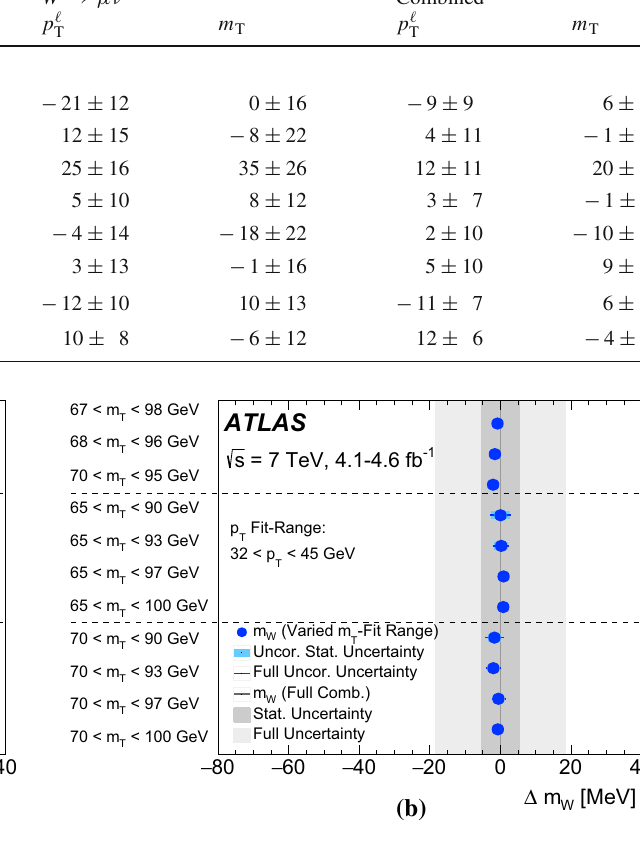
Fig. 27 Stability of the combined measurement of m W with respect dependence on variations of the lower (upper) boundary for two values to variations of the kinematic ranges of a p (cid:7) and b m T used for the of the upper (lower) boundary for p (cid:7) T solid lines respectively show the statistical and total uncertainty on the template fits. The optimal m T range is used for the p (cid:7) variations, and T difference with the optimal the optimal p (cid:7) range is used for the m T variations. The effect on the T result of symmetric variations of the fitting range boundaries, and its